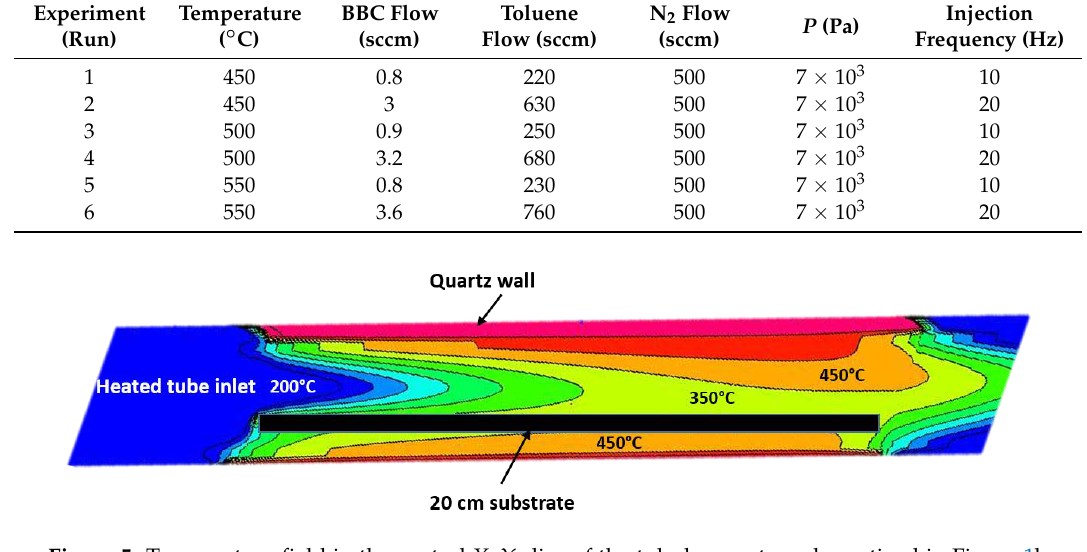
Figure 5. Temperature field in the central X – Y slice of the tubular reactor schematized in Figure 1b (Table 4, Run 1).